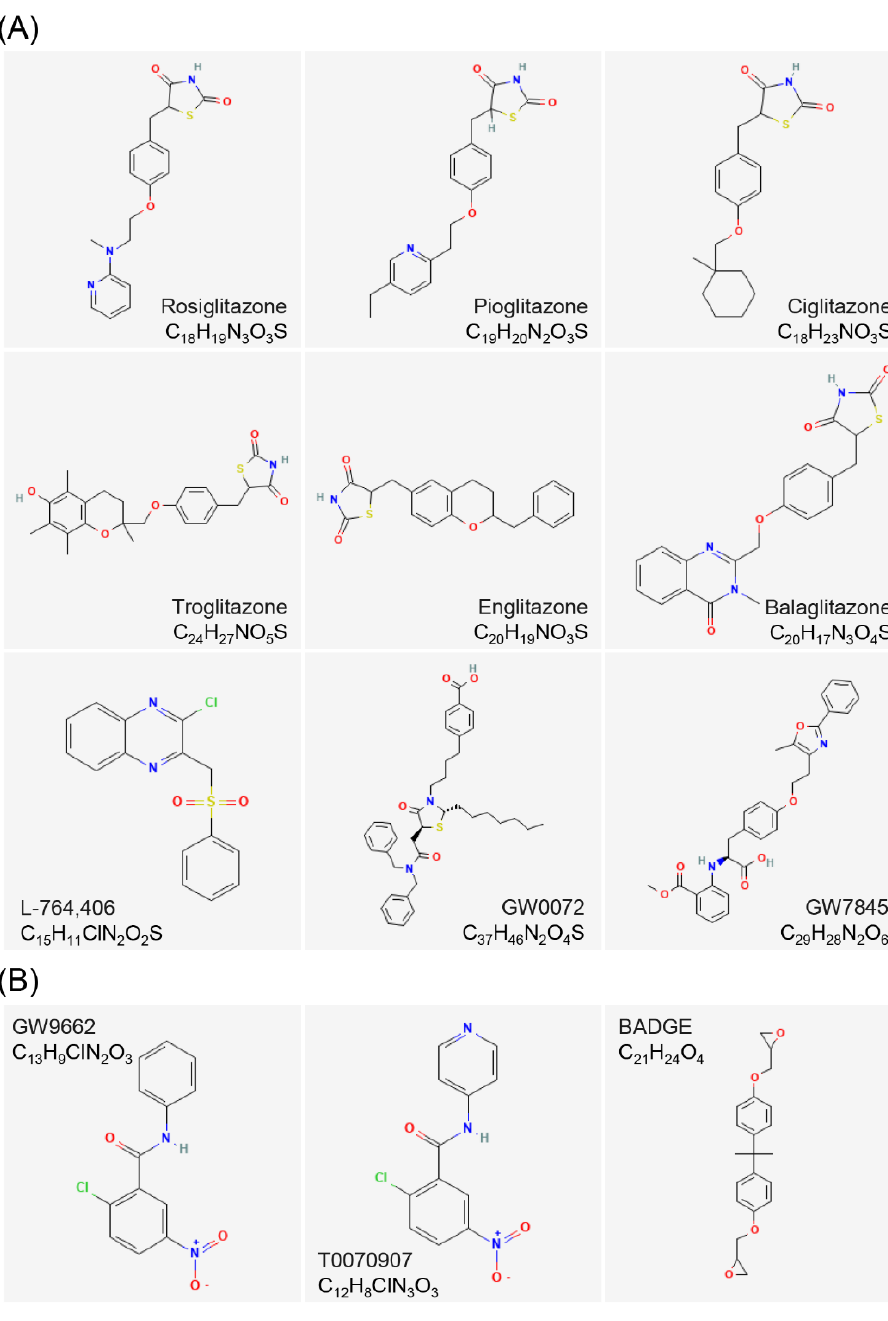
Figure 5. Agonist ( A ) and antagonist ( B ) secondary structures of